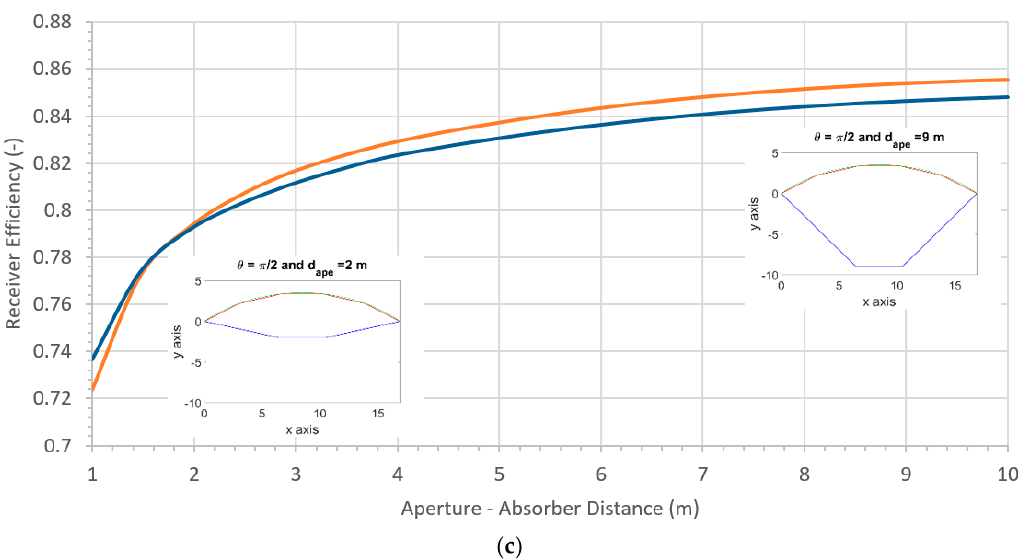
Figure 6. Influence of the aperture—absorber distance on the radiative; ( a ) and convective losses ( b ), both normalized by the receiver power, and on the receiver efficiency; ( c ), for the following parameters: M = 5 panels, L ape = 4 m, H ape = 5 m and α = 0.